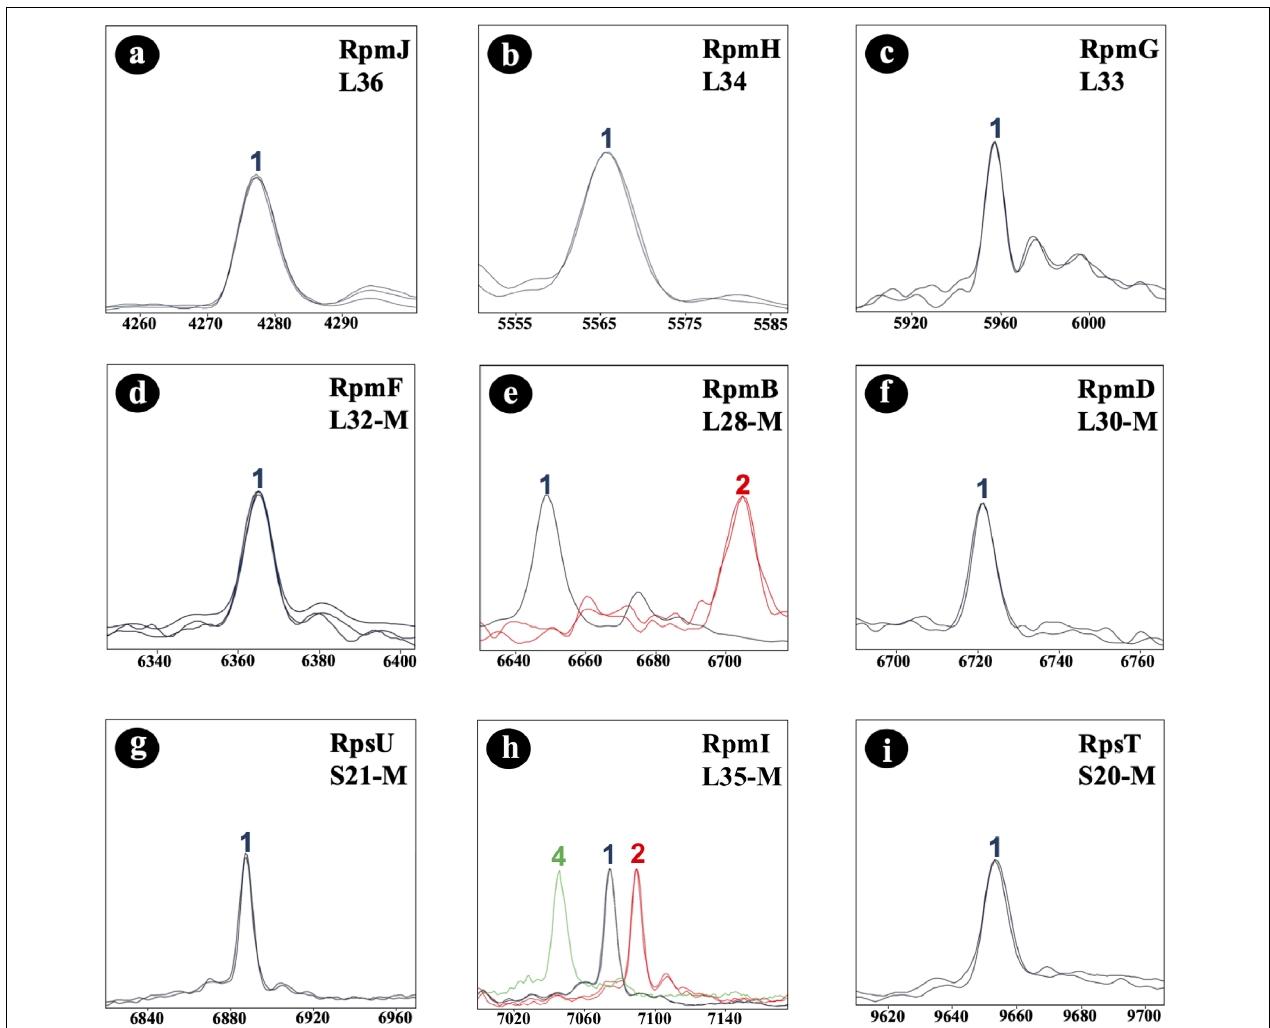
FIGURE 3 | C. difficile -specific proteotyping-derived biomarkers (a–i) . In order to demonstrate mass differences between allelic isoforms, spectra of representative C. difficile isolates of each of the five detected proteotyping-derived types were overlaid. X -Axis: mass [Da] charge-1 ratio, scale 200 Da. Y -Axis: intensity [10 × arbitrary units], spectra were individually adjusted to similar noise in order to improve visualization of peaks with low-intensity. Color codes: the isoform of C. difficile reference strain 630 (= DSM 27543) is depicted in blue; red and light green indicate isoforms that differ in their mass from the reference strain 630 (= DSM 27543). Isoforms lacking N -terminal methionine are appended with